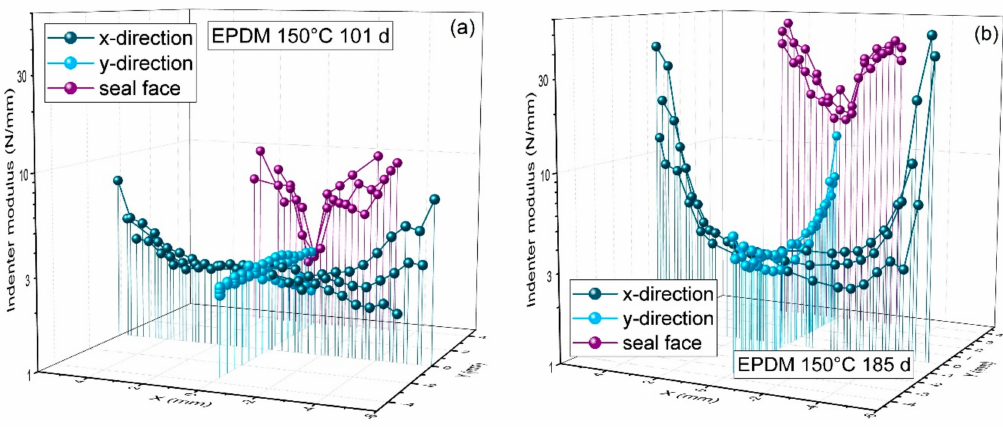
Figure 13. Indenter modulus profiles on the O-ring cross-section in x-direction (dark blue), in y-direction (light blue), and across the seal face in x-direction (purple) determined on EPDM O-rings aged at 150 ◦ C for ( a ) 101 days and ( b ) 185 days (half a